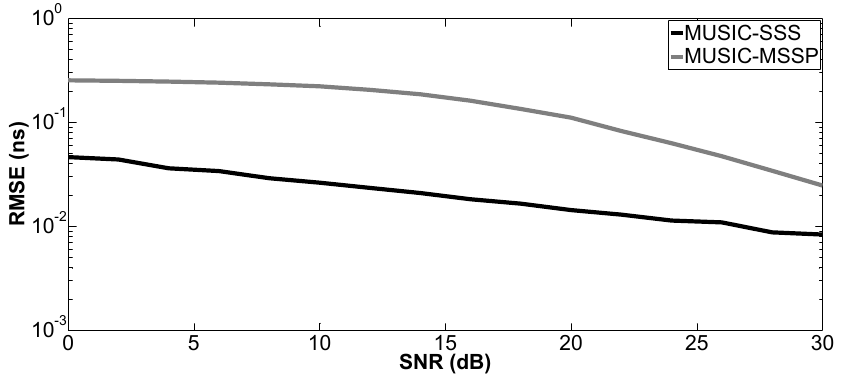
Figure 5. RMSE on the estimated time delay ˆ t 2 versus SNR.